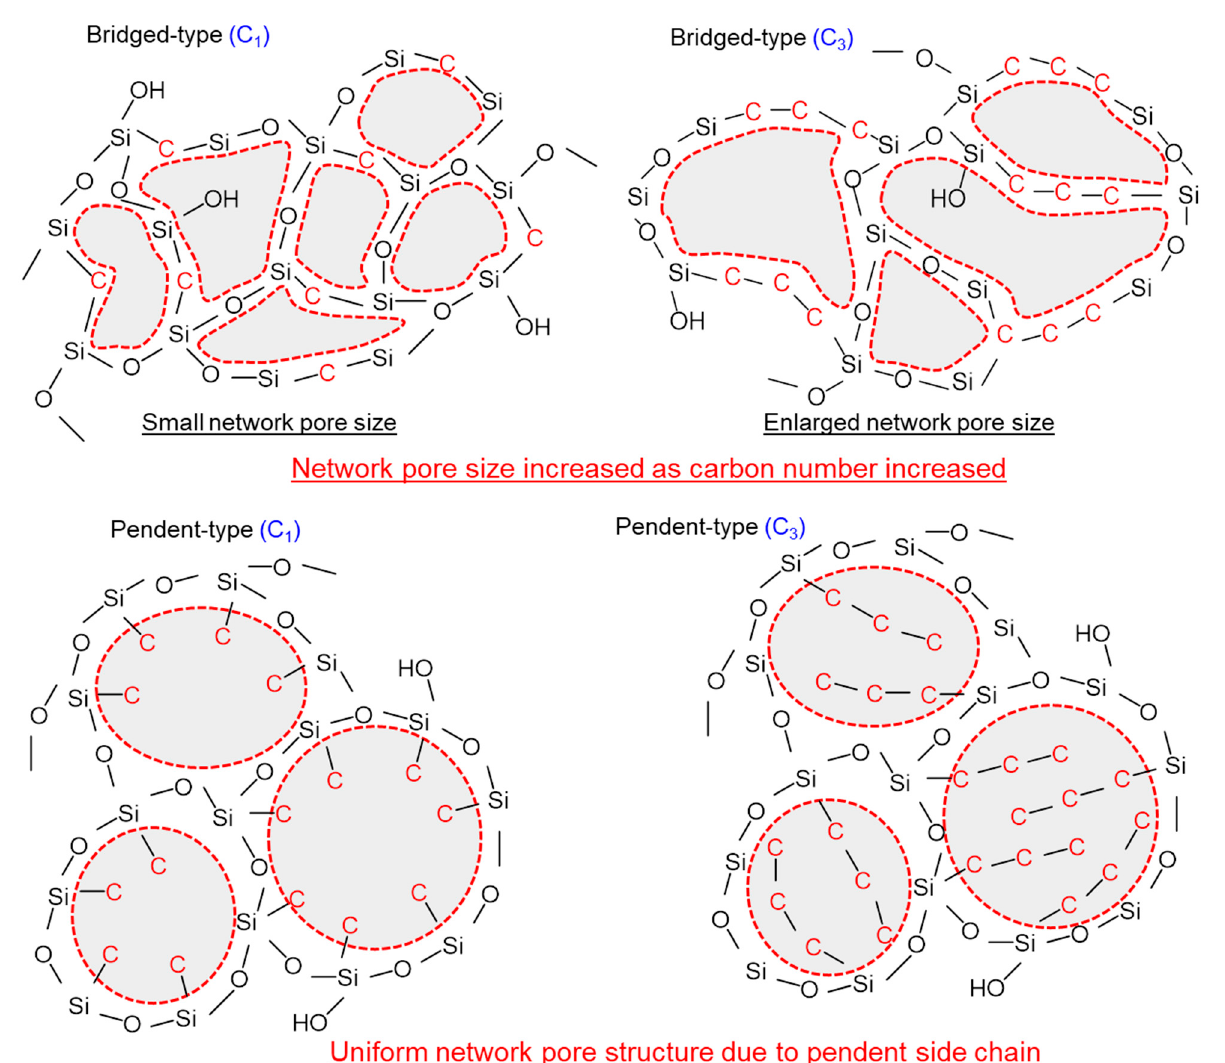
Figure 5. Effect that C/Si ratio exerts on pendant-type and bridged–type organosilica network pore sizes.